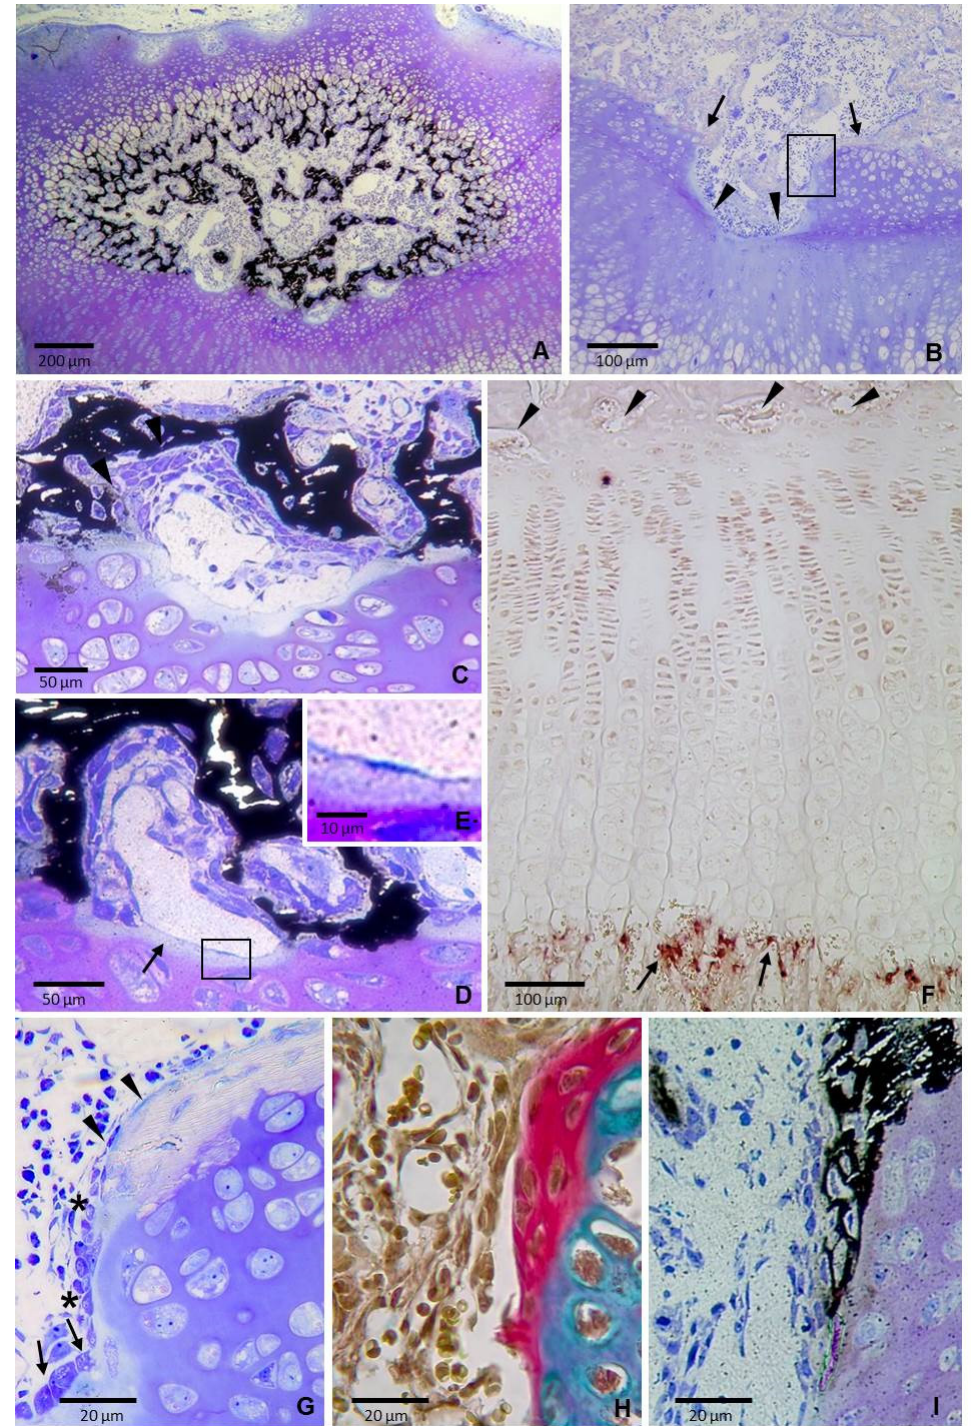
Figure 2. Sections of the tibial epiphysis of 19 day-old rats. ( A ) Section stained with von Kossa and counterstained with toluidine blue showing that the epiphyseal bony tissue displays a “bicycle wheel” pattern at the upper portion and a bridge-like disposition at the lower portion. ( B ) Semithin section stained with toluidine blue showing rounded hollows (arrowheads) and ridges (arrows) in the epiphyseal cartilage. Boxed area is shown at a higher magnification in figure G. ( C ) Section stained with von Kossa and counterstained with toluidine blue showing that the cell composition differs between the upper and lower surfaces of the mineralized plate-like elements. ( D ) Section stained with von Kossa and counterstained with toluidine blue showing a moderately dilated capillary interposed between the cartilage and the bone forming cells. It is close to the surface of the cartilage, where a thin band of less stained cartilaginous matrix is